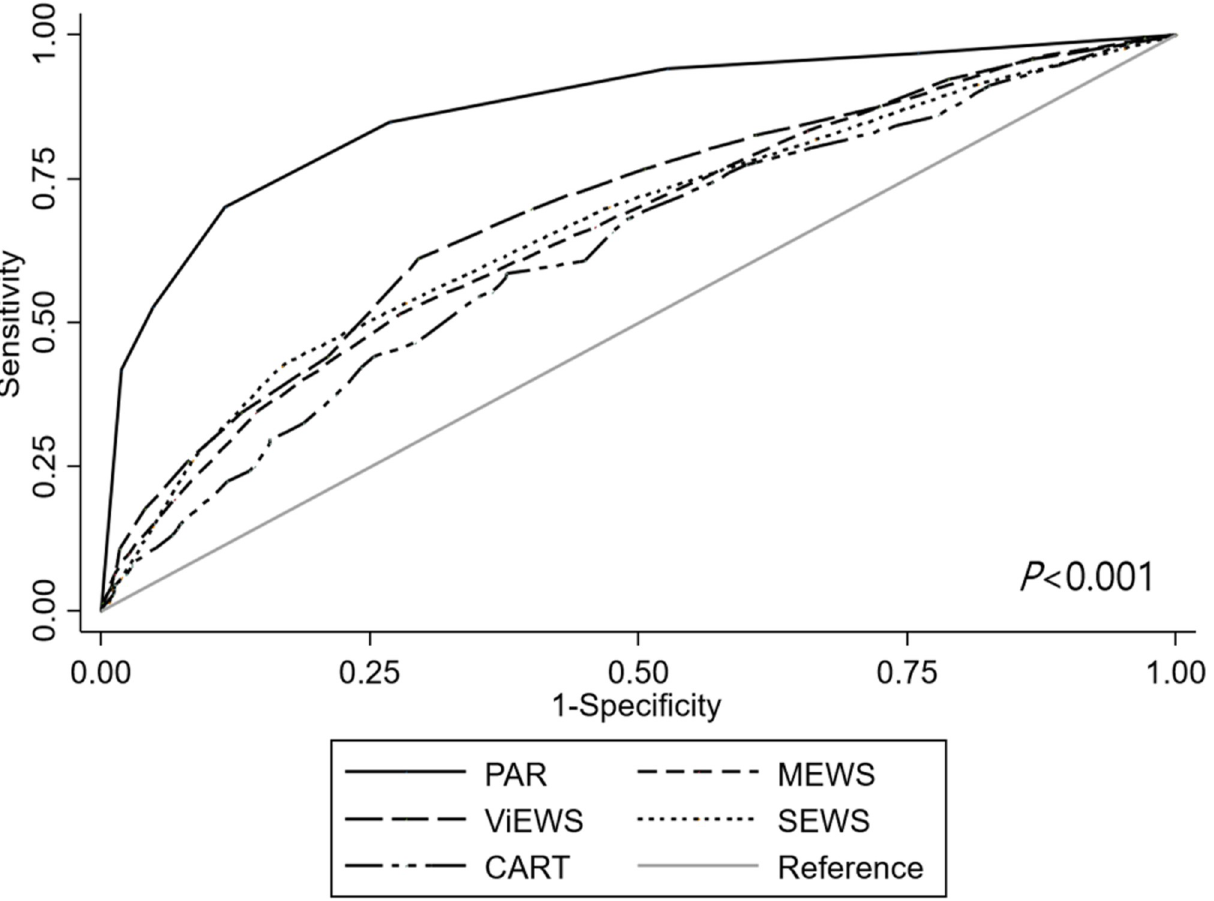
Fig 1. Receiver operating characteristic curve of each score. Patient Acuity Rating assessed by the rapid response team nurse was superior in predicting mortality and/or intensive care unit admission within the next day, compared to several other early warning scores.